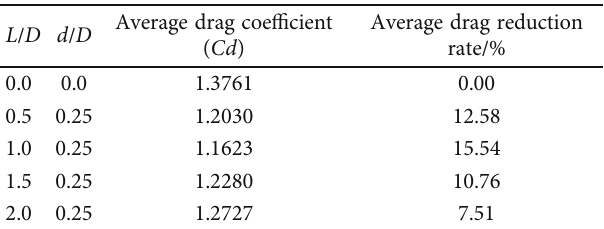
Figure 8: Time-averaged streamline (pitch angle 0 ° ; phase angle 0 ° ). Table 5: Average drag reduction conditions of aircraft with di ff erent L / D .